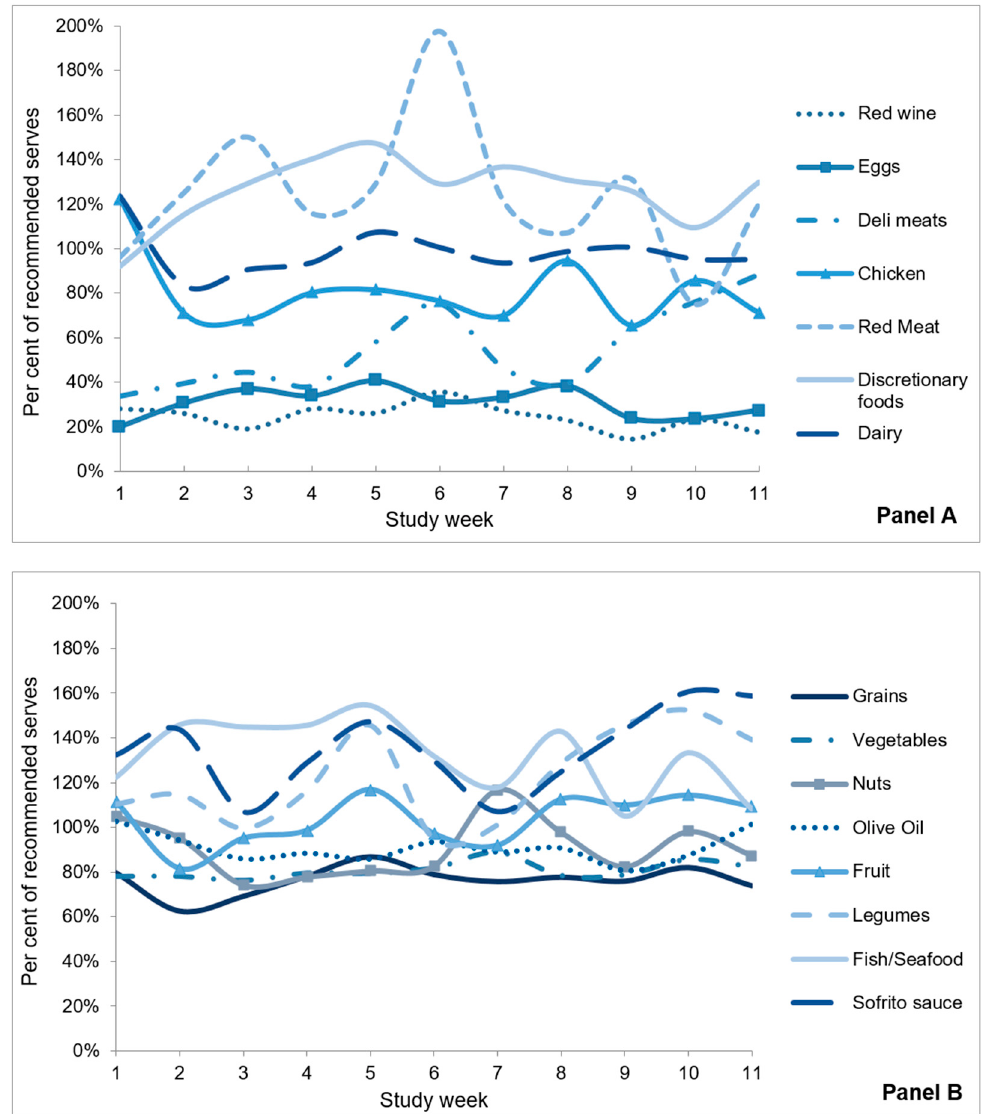
Figure 3. Percentage of recommended dietary servings consumed by study week. Panel ( A ): Foods for which there was a maximum weekly recommendation for serves. Panel ( B ): Foods for which there was a minimum daily or weekly recommendation for serves.